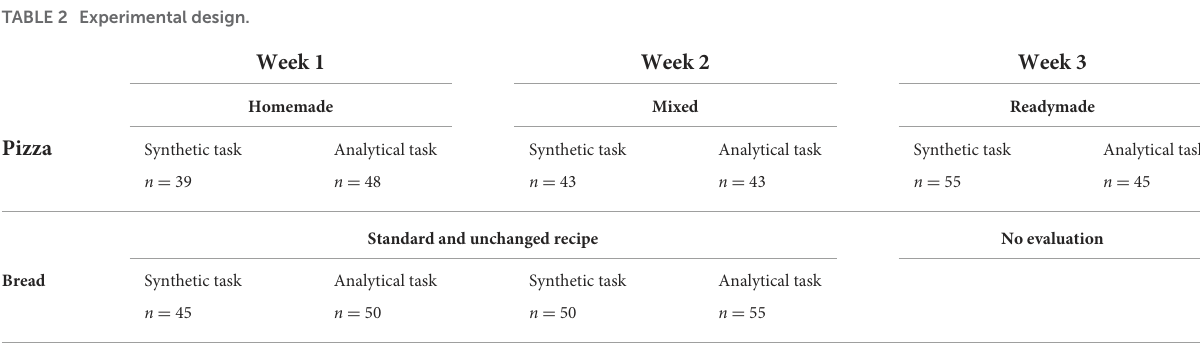
TABLE 2 Experimental design.